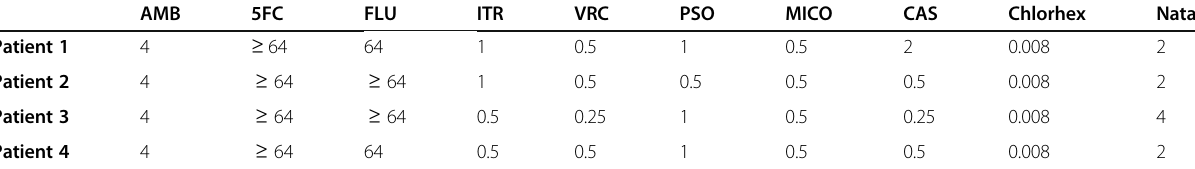
Table 2 MICs ( μ g/ml) of different antifungal drugs on the P. boydii